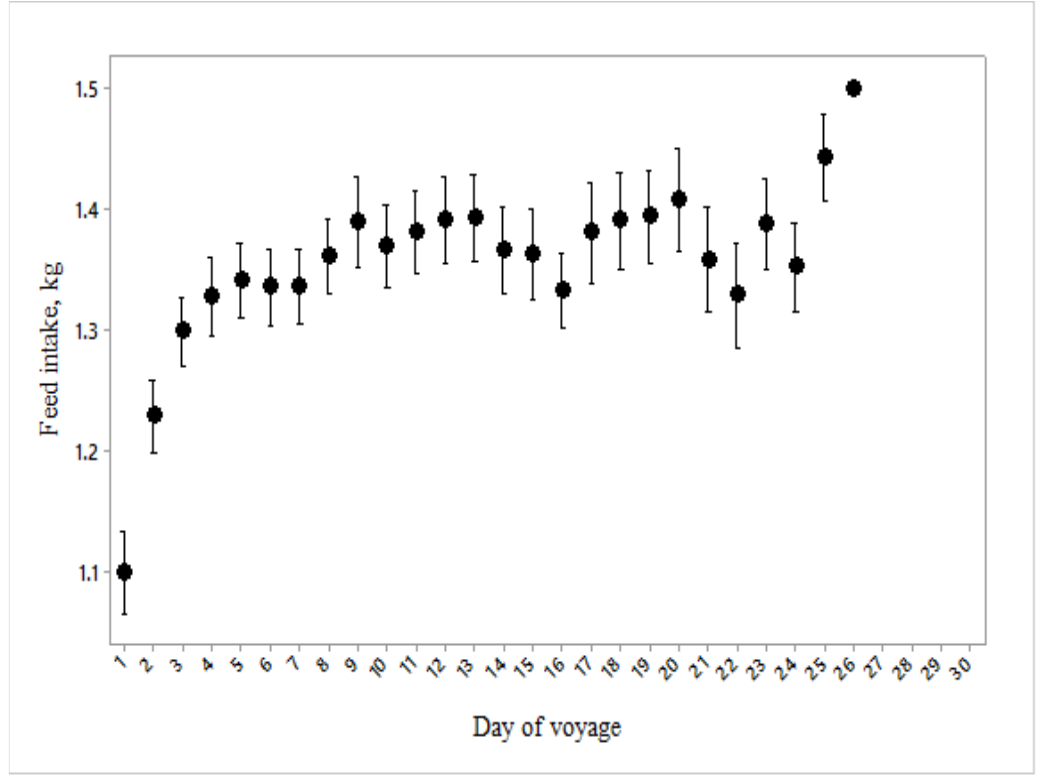
Figure 13. Feed consumption per sheep over the 27 days of the voyage ( n = 3784). Animals 2020 , 10 , x FOR PEER REVIEW